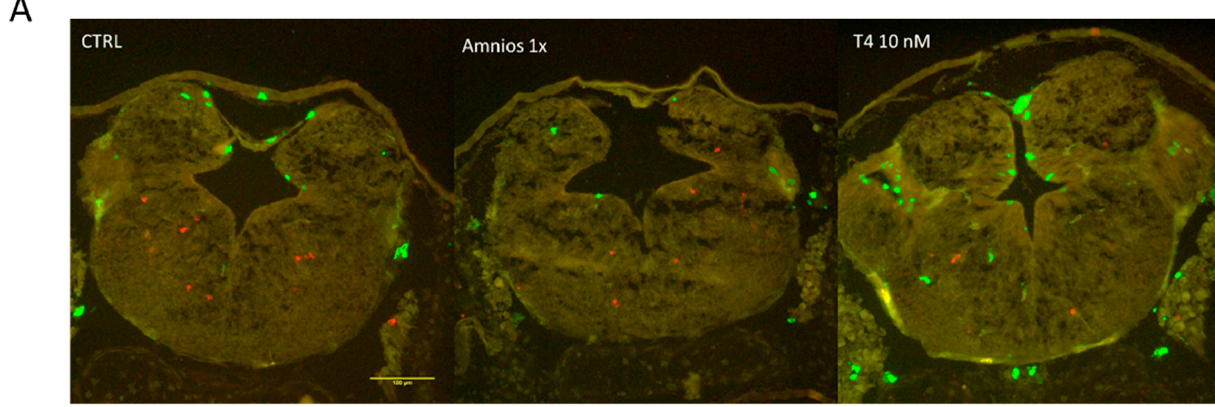
Figure 6. Effect of Amnios 1X and T 4 on proliferation and apoptosis in tadpole brains. For each treat- ment group, 2 tadpoles from 3 different females were analyzed. ( A ) Example cross-sectional images of brains following immunochemistry: apoptosis marker in red (caspase3), proliferation marker in green (PH3). Scale bar, 100 µm. ( B ) Average number of positive cell nuclei per section for caspase3 and PH3, and the ratio of proliferative/apoptotic cells. Figure 7. Behavioral study of tadpoles exposed to amniotic mixture and T 4 (10 nM). The normalized distance was measured during 10 min trials with 30 s light/30 s dark alternation using Video track- ing Noldus Ethovision system. NF 47 tadpoles, directly after 8-day exposure to either ( A ) the